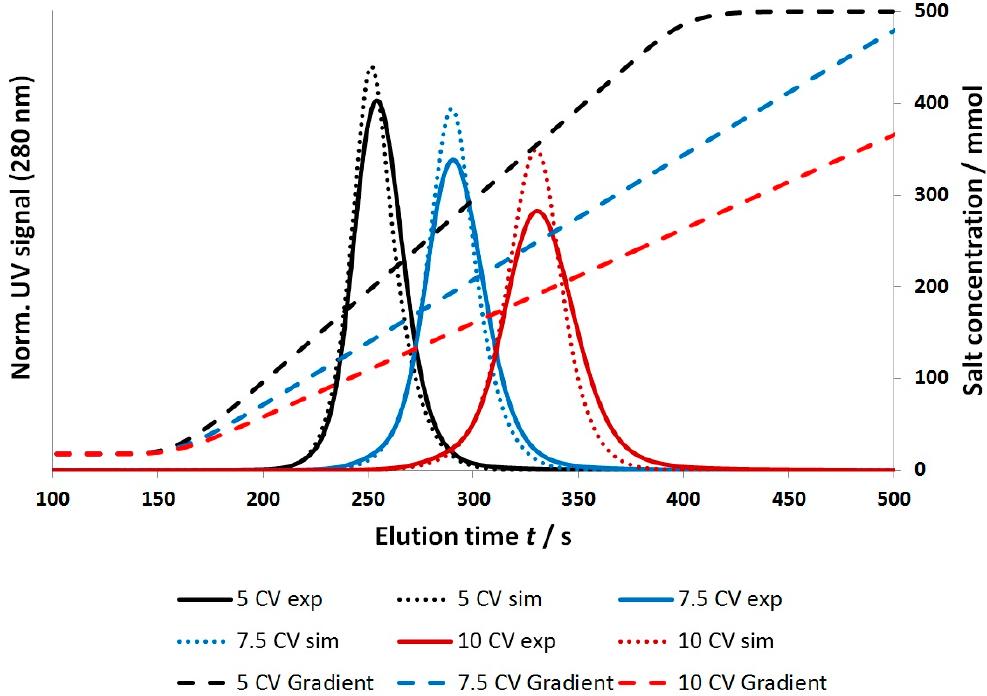
Figure 10. Comparision between the measured and simulated signals for a bind and elute experiment using purified mAb1. Binding and wash buffer: 10 mM KPi, pH = 6, 20 mM NaCl; elution buffer: 10mM KPi, pH = 6, 500 mM NaCl; 5–10 CVs gradient duration; flow rate: 3 mL/min.